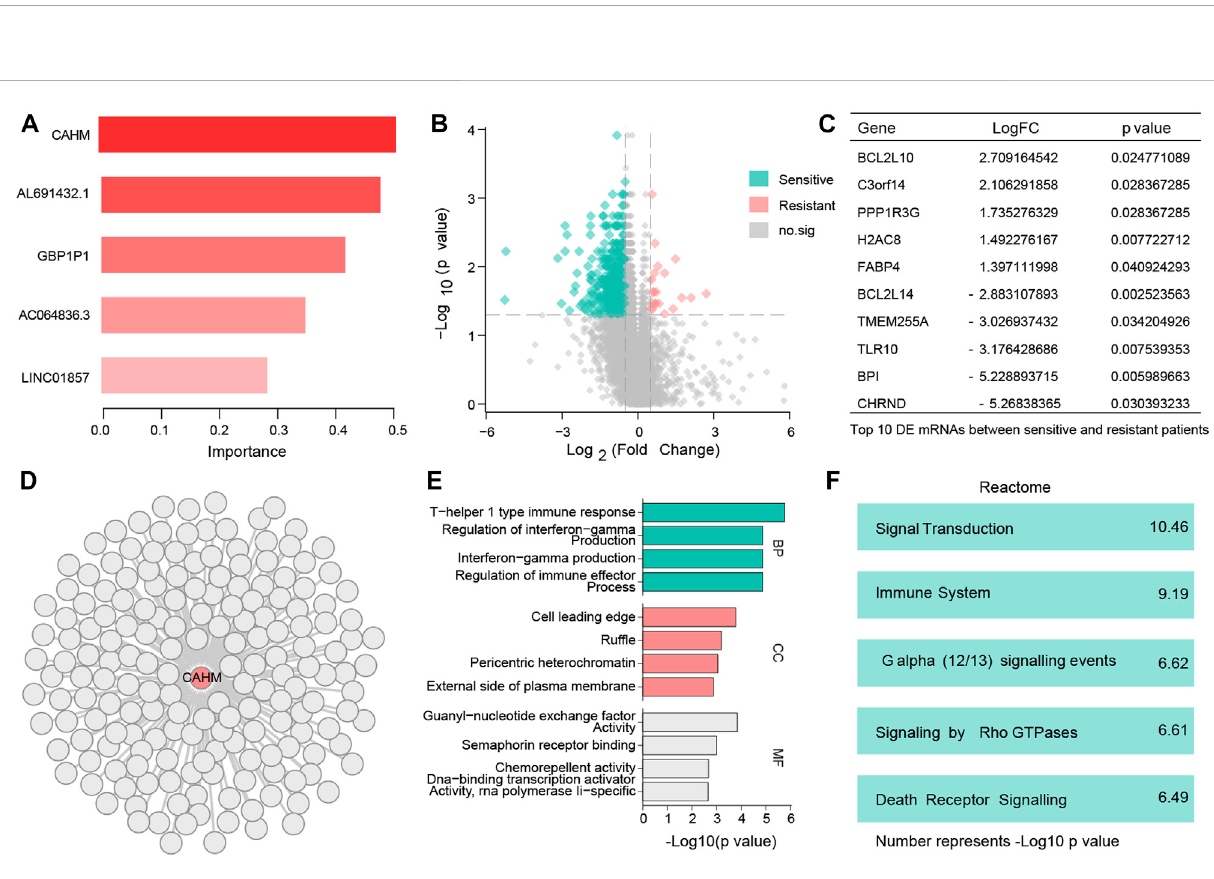
IdentifyhubLncRNACAHMandexploremolecularfunctionofthisLncRNA (A) Barchartshows5resistantgenes. (B) 652DEmRNAswereidenti fi ed. (C) Top 10 DE mRNAs with the largest change multiples. (D) 181 DE mRNAs were positively correlated with CAHM. (E) Gene Ontology (BP, CC, and, MF) analysis of CAHM. (F) Reactome analysis of